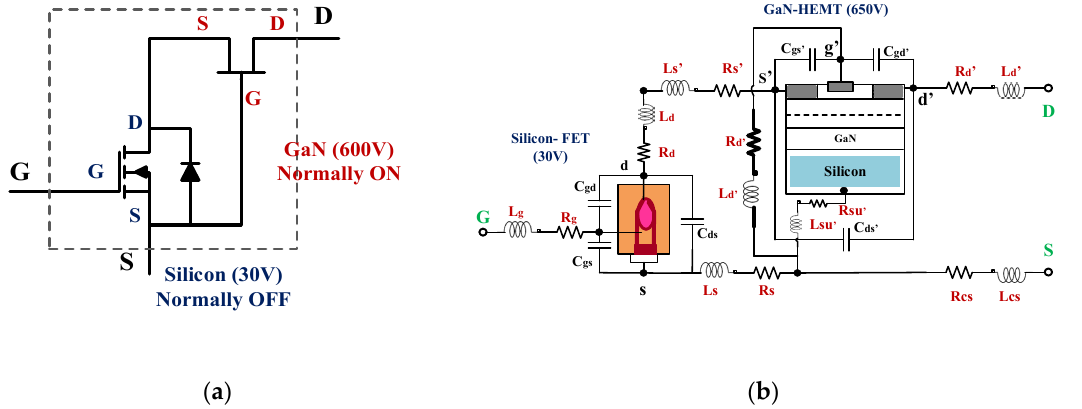
Figure 4. ( a ) Cascode GaN HEMT TO-220 package; and ( b ) simplified bonding diagram (adapted from [29]).